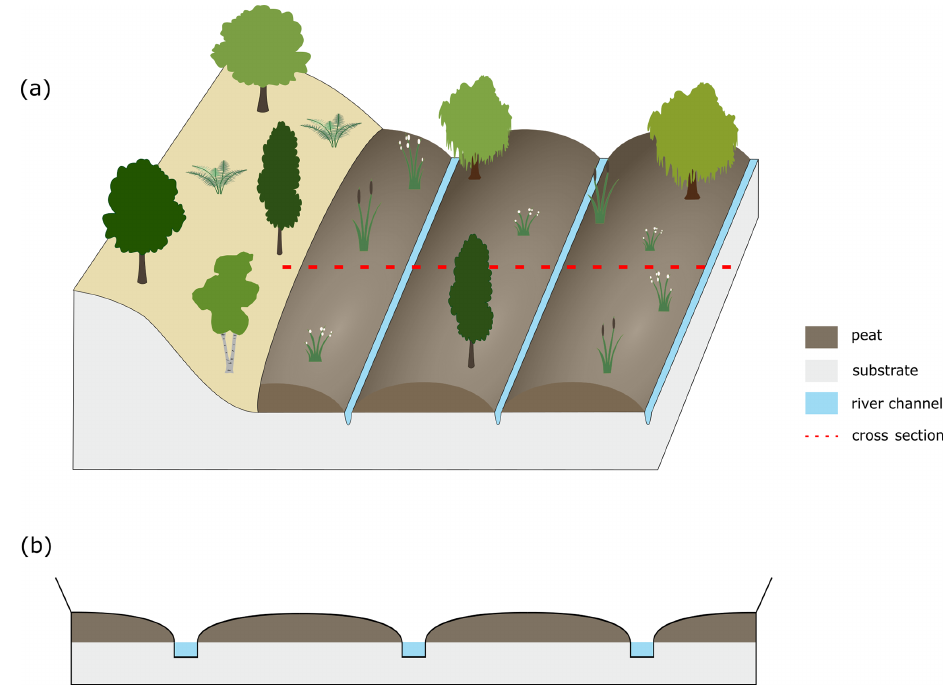
Figure 3. Conceptual drawing of the model domain. (a) Landscape setting of the alluvial peatland, represented by elliptic bogs on top of an impermeable substrate with straight river channels. The red dotted line indicates the cross-sectional location. (b) Schematic floodplain cross-sectional drawing. The 1D model simulates the peat profile at the centre of a single elliptic